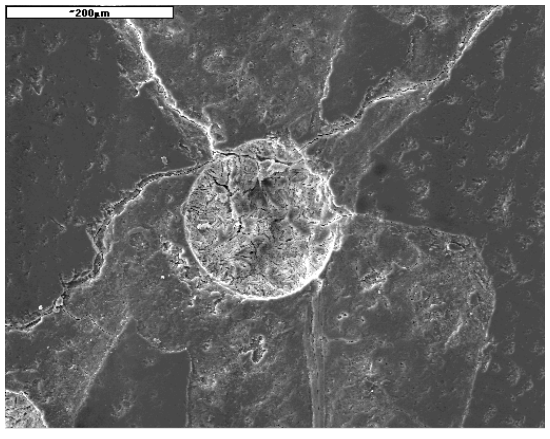
Fig 9. SEM image of alkali-silica gel at